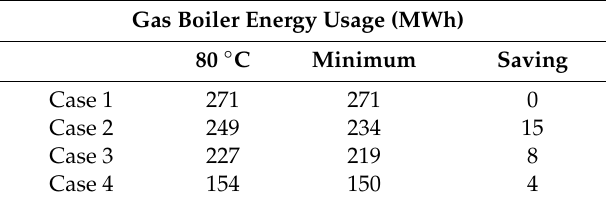
Table 6. Gas boiler energy usage.